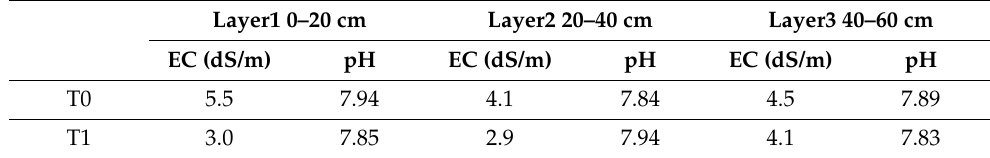
Figure 1. Evolution of soil moisture at 10 cm depth (a) From 4 to 11 October. The electric conductivity (EC 1/5 : (dS/m) and pH of the different layers were measured from representative samples of the plots. The measured values show that at all horizons, the electrical conductivities of the plot irrigated with magnetically treated water are lower than those of the control, Table 4 bellow summarizes the variation of conductivity and pH. Table 4. Soil Conductivity and pH .